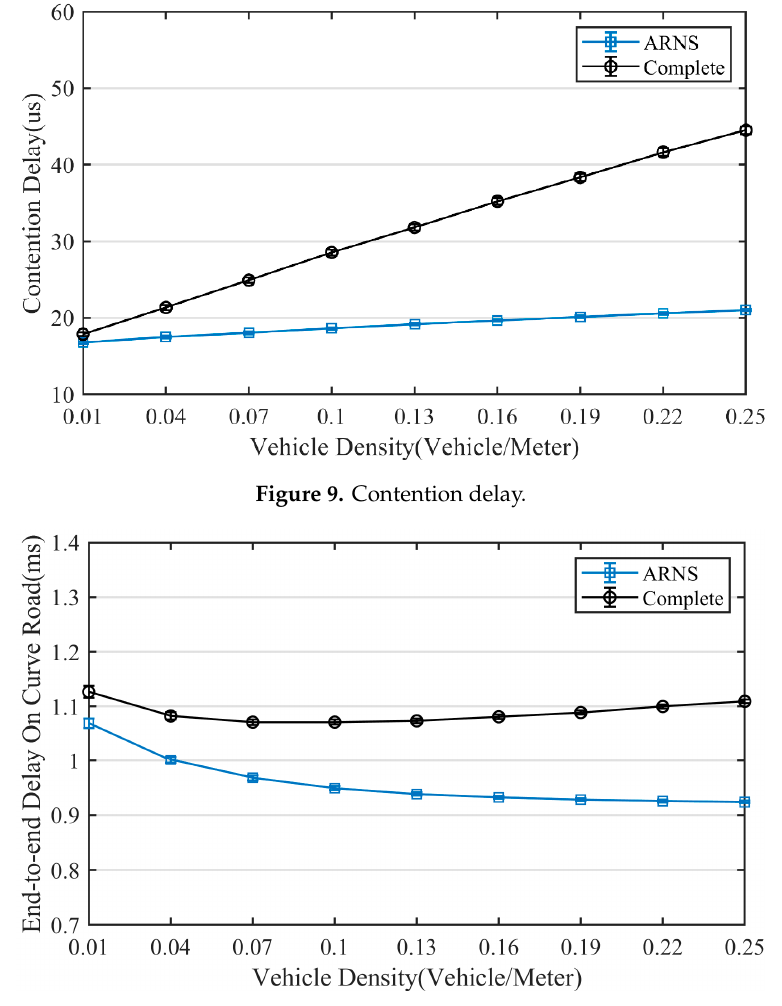
Figure 10. End-to-end delay on the curved road.